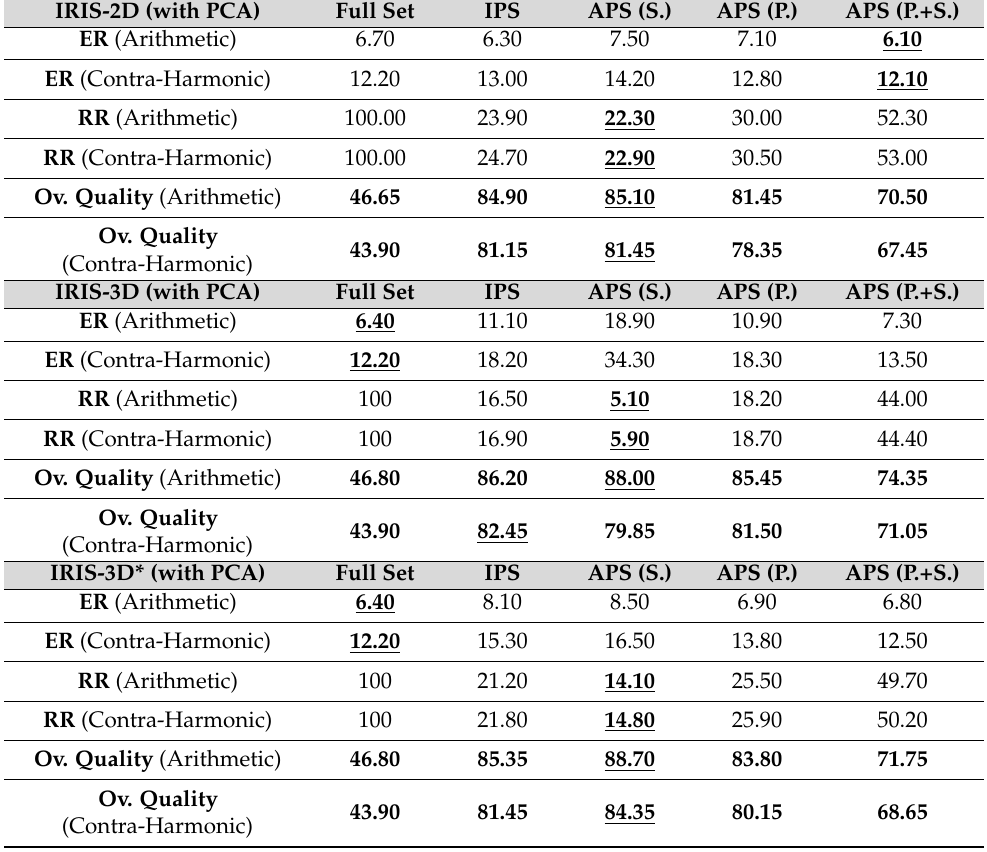
Table 6. Results of the experiments with the quasi-orthogonal projections algorithm in 3D applied to the Iris dataset. Here, one can see the performance of IPS and APS algorithms in 2D, and also (for comparison) there are results in 3D provided by two options of the QOP